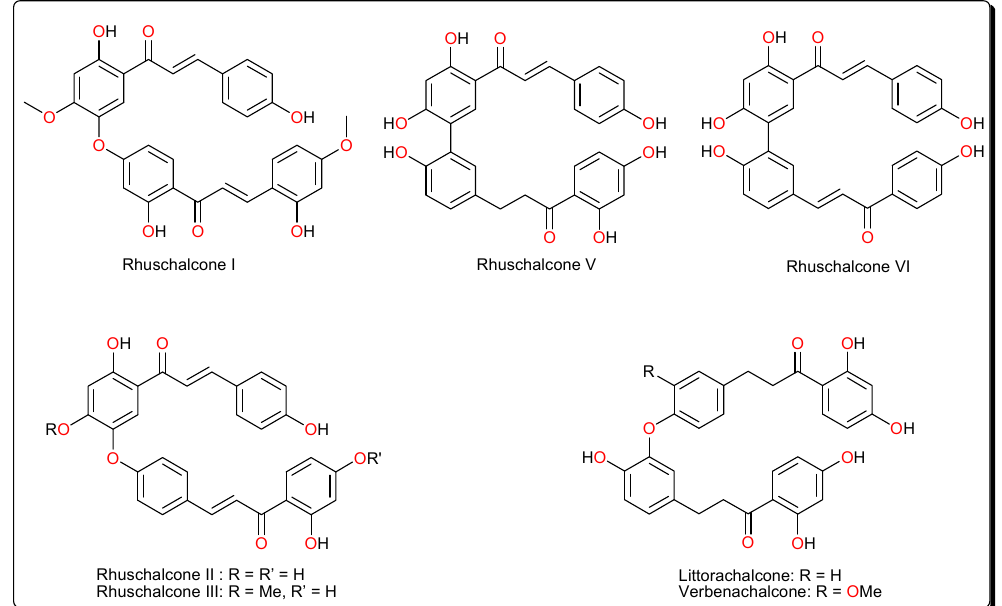
Figure 2. Untested bichalcones from Rhus species.